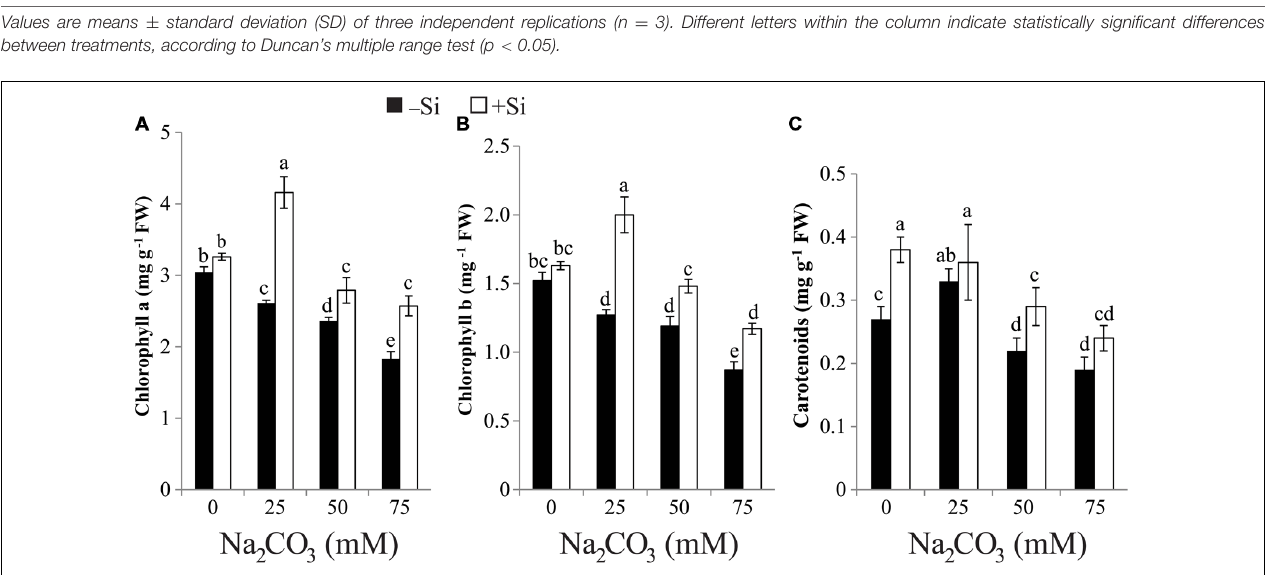
FIGURE 1 | Effects of different levels of alkaline stress with and without seed-priming with silicon (Si) on the contents of (A) chlorophyll a, (B) chlorophyll b and (C) carotenoids in leaves of 25-day-old maize plants. Bars represent standard deviation (SD) of the means ( n = 3). Different letters indicate significant differences among the treatments at P < 0.05, according to Duncan’s multiple range test. FW, fresh